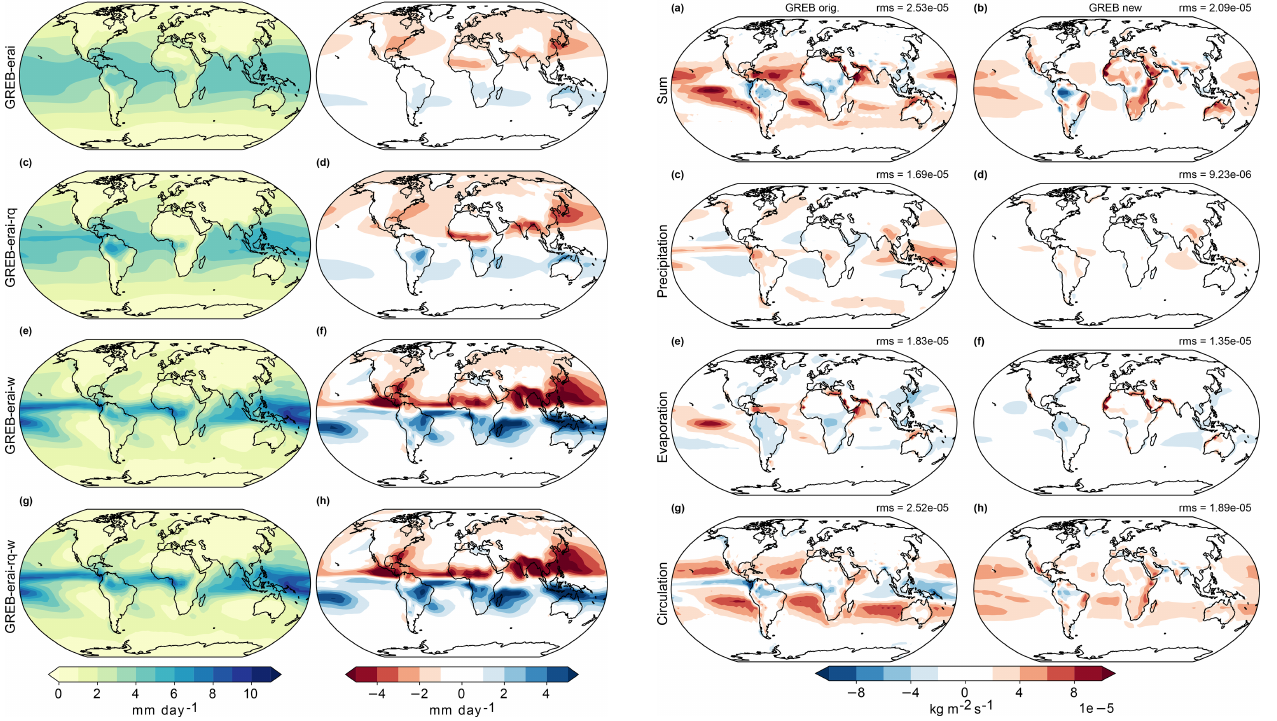
Figure 6. Annual mean flux corrections of specific humidity for the original GREB model (a) and the improved GREB model (b) . The flux corrections are then split into their contributions of precipita- tion (c, d) , evaporation (e, f) and circulation (g, h) for the original GREB model (a, c, e, g) and the improved GREB model (b, d, f, h) in kgm − 2 s − 1 . The top right corner of each panel shows the global root mean square